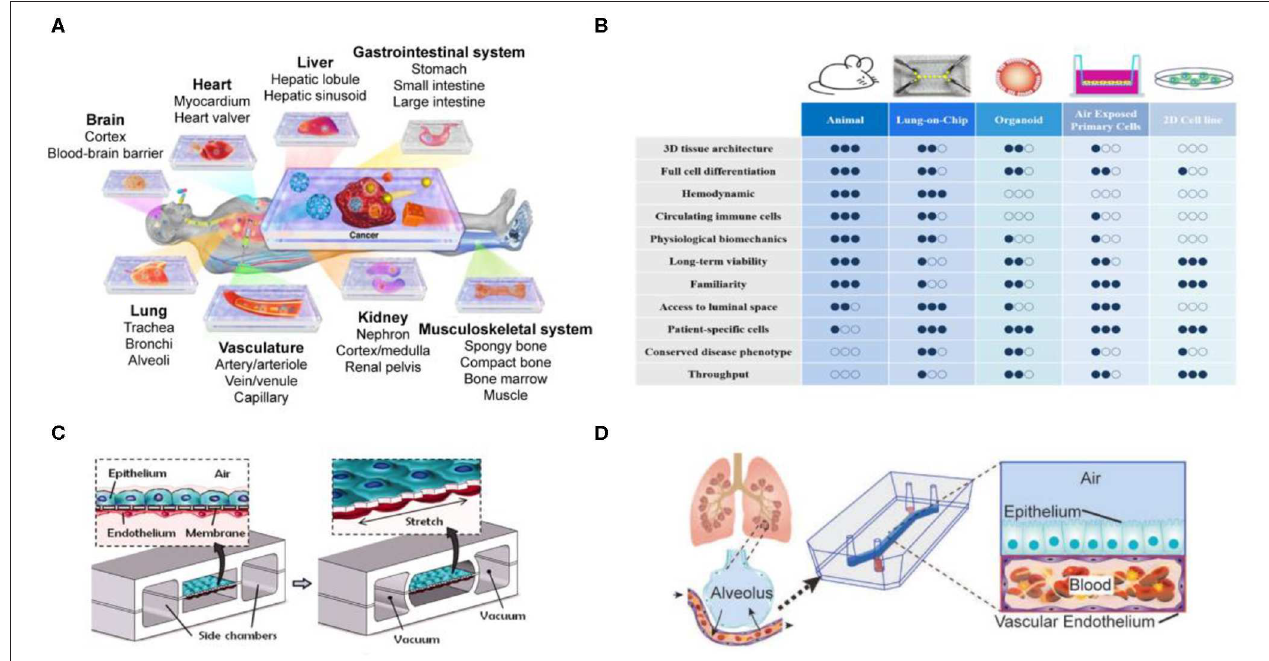
FIGURE 3 | Organs-on-chips technology for tissue model development . (A) Organs-on-chips platform provides an in vitro model of various organs. Reproduced with permission from Zhang et al. (2017). (B) Comparison of experimental strategies for current in vitro , in vivo , and Organs-on-chips models. Adapted with permission